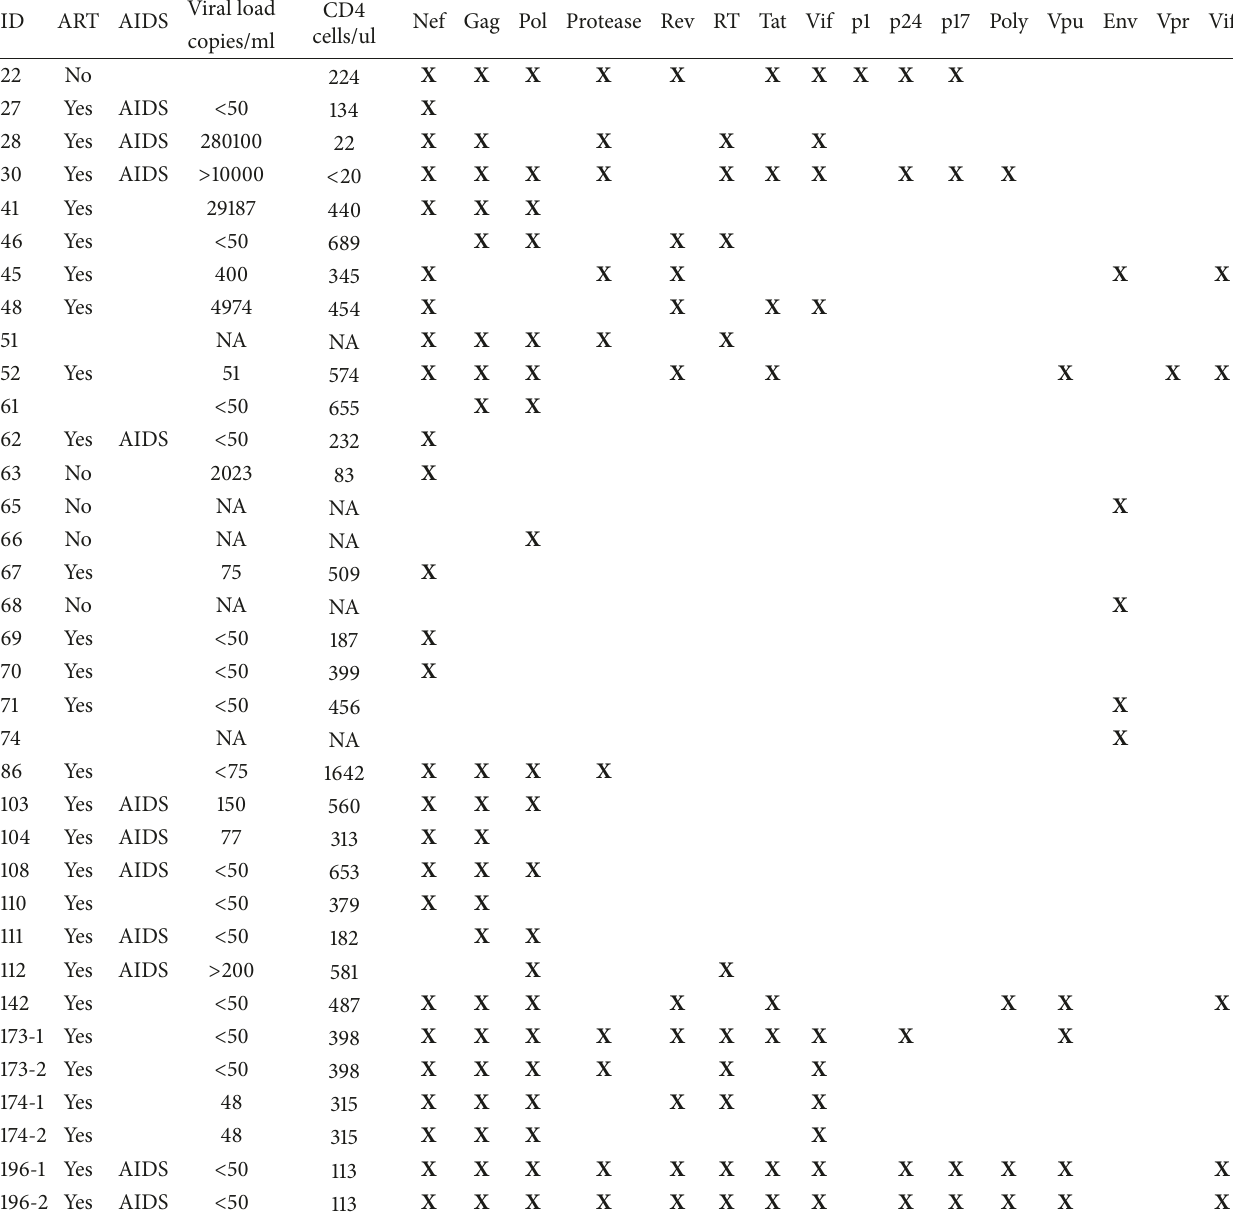
Table 3: Presence of HIV-1 proteins in HIV+ patient urinary